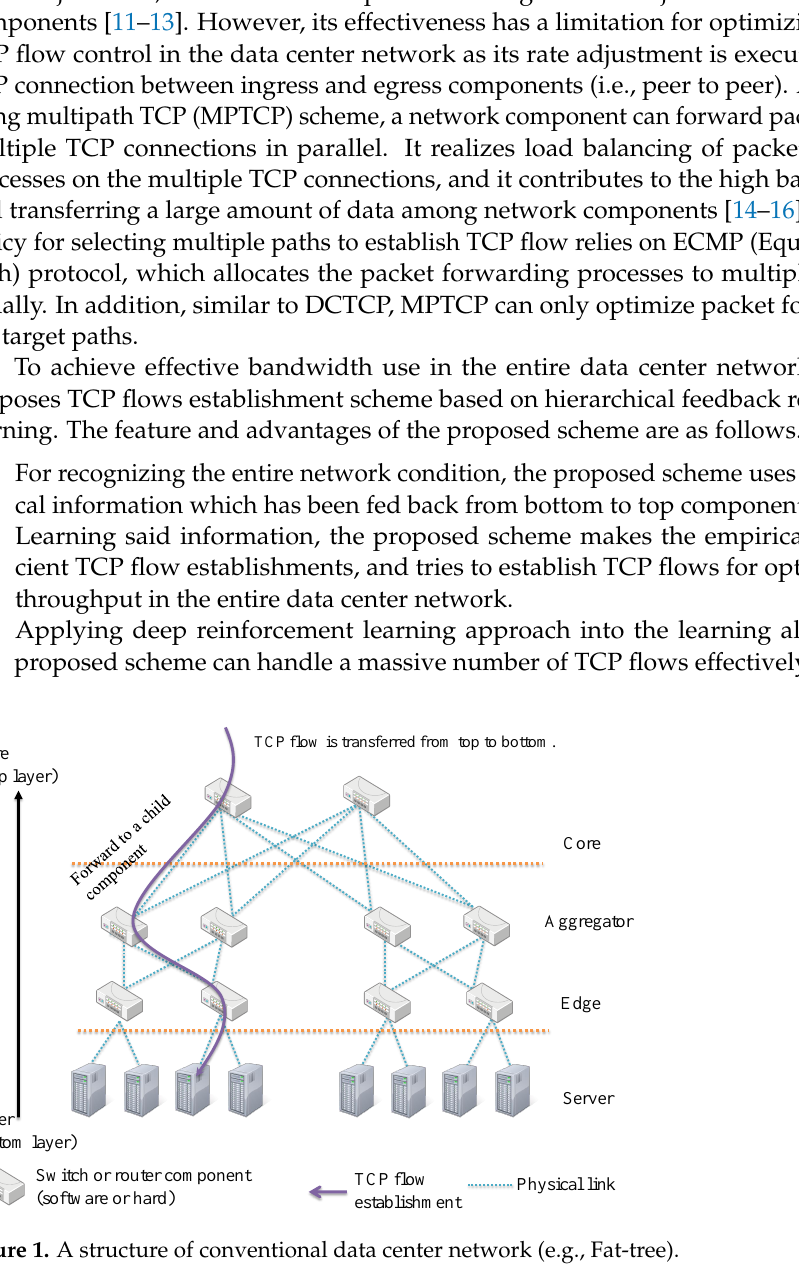
Figure 1. A structure of conventional data center network (e.g.,